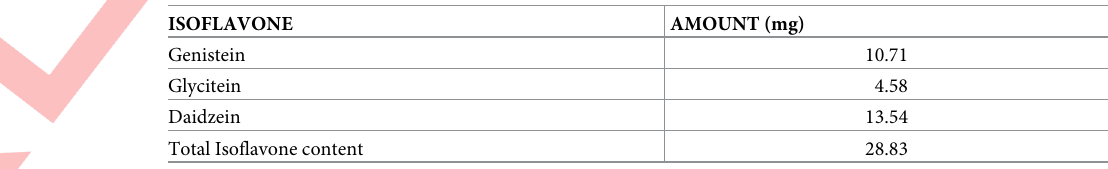
Table 3. Quantification results of isoflavones.